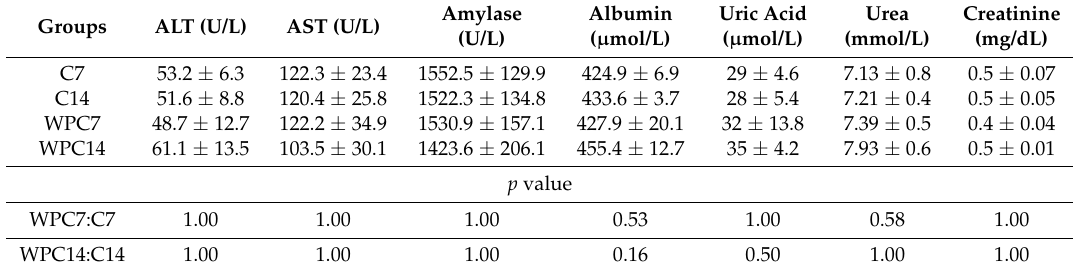
Table 2. Plasma biochemical parameters of rats from control and experimental groups. Abbreviations: ALT, alanine aminotransferase; AST, aspartate aminotransferase; C7, C14, control groups; WPC7, WPC14, experimental groups treated WPC-80. Data are presented as mean ± SD. Because the results were normally distributed, a Student’s t -test was used to compare differences between the studied groups.